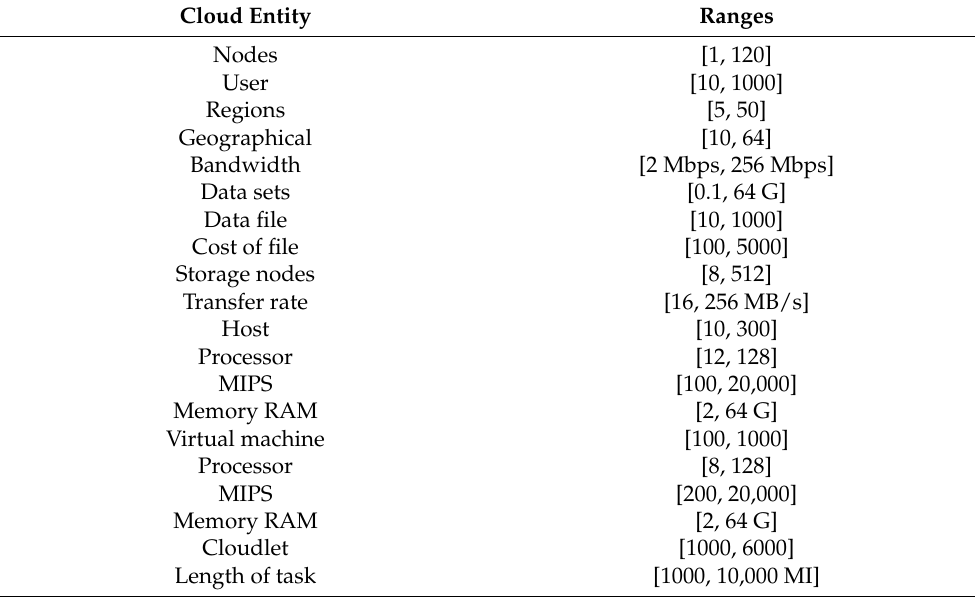
Table 2. Parameters data sets of the